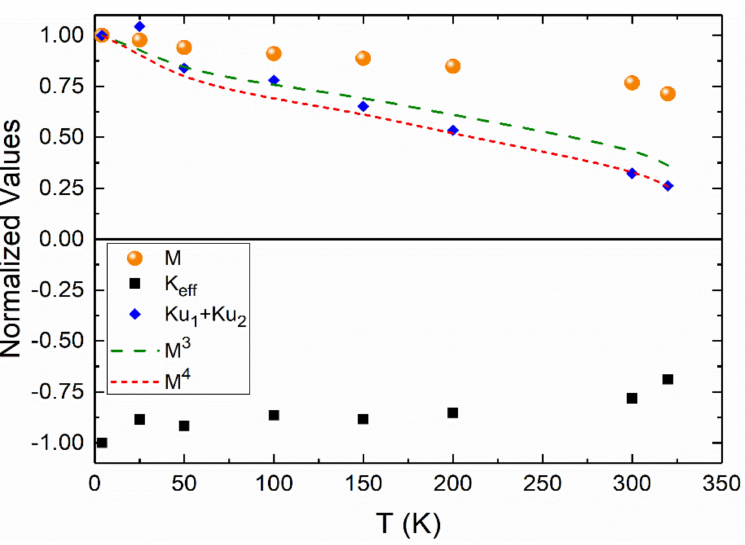
Figure 8. Temperature-dependent magnetizations and anisotropies, as indicated, for the multilayer with t NiFe = 5.1